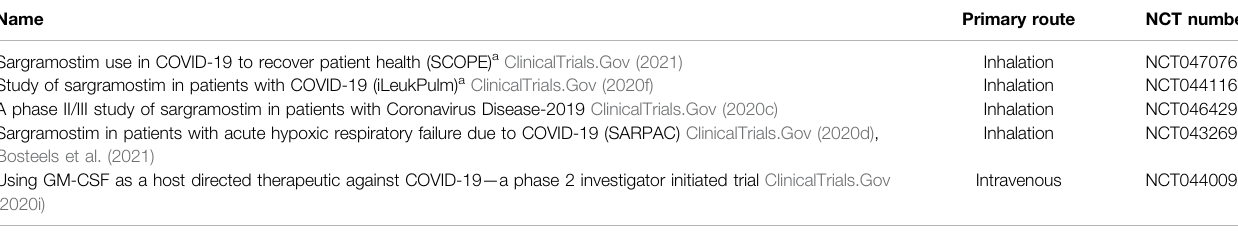
TABLE 2 | Sargramostim clinical studies in